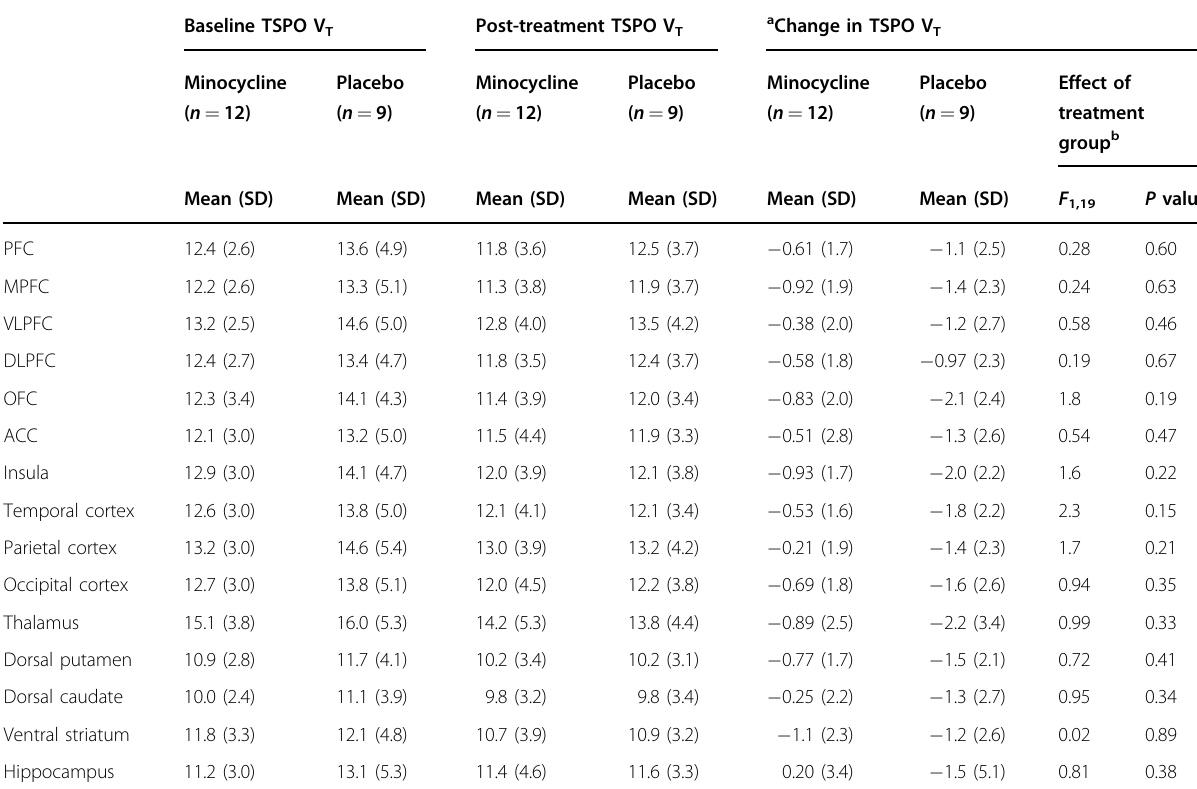
Table 2 Effect of oral minocycline treatment on regional translocator protein total distribution